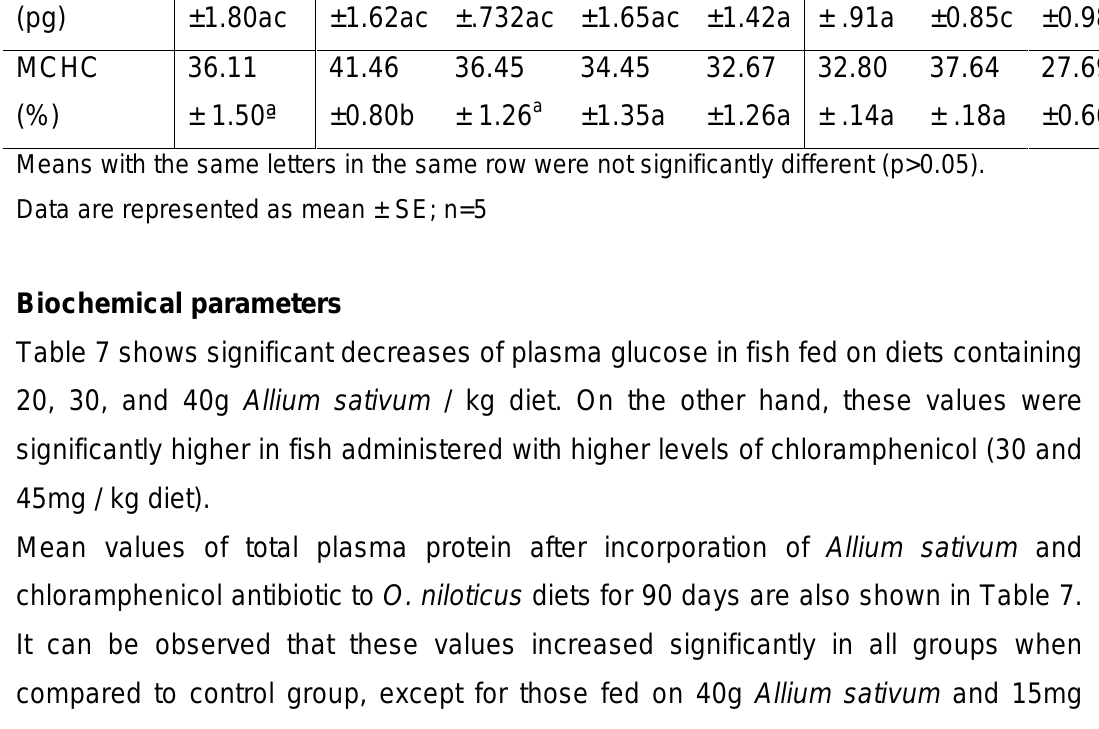
Table 6: Changes of mean corpuscular volume (MCV), mean corpuscular hemoglobin (MCH), and mean corpuscular hemoglobin concentration (MCHC) in the blood of O. niloticus fed on diets containing different levels of Allium sativum and chloramphenicol. Treatments Control Allium sativum levels Chloramphenicol levels (g/kg diet) (mg/kg diet) Parameters (0) 10 20 30 40 150 30 45 MCV 93.40 100.0 85.74 87.0 74.17 96.1 100.78 (µm 3 ) ± .18a ±4.26b ±3.58b MCH 33.73 33.69 36.45 34.46 37.64 27.69 (pg) ±1.80ac ±1.62ac ±.732ac ±0.85c ±0.98b MCHC 36.11 41.46 36.45 34.45 32.67 32.80 37.64 27.69 (%) ± 1.50ª ±0.80b ± 1.26 a ±1.35a ±1.26a ± .14a ± .18a